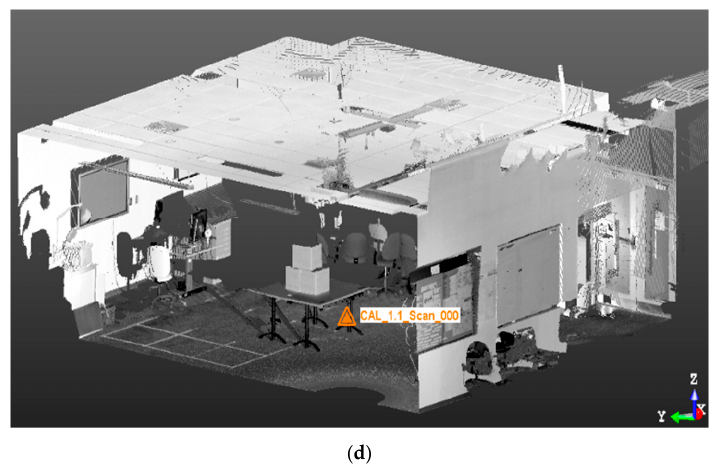
Figure 1. Various remote sensing technologies. ( a ) Automated data acquisition on site; ( b ) RFID system; ( c ) UWB system; ( d ) point cloud data for 3D modeling.